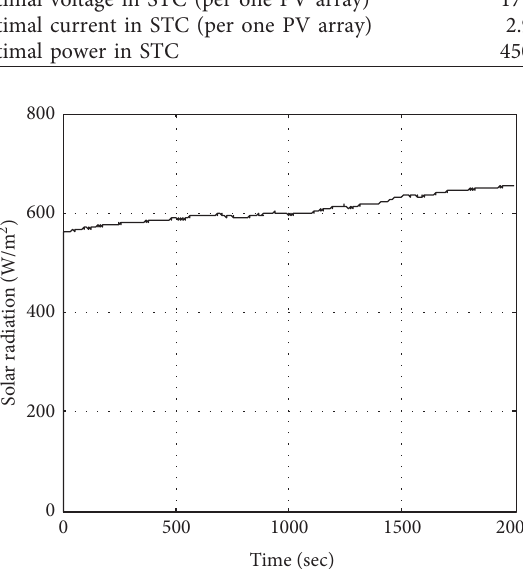
Figure 10: Evolution of solar radiation.